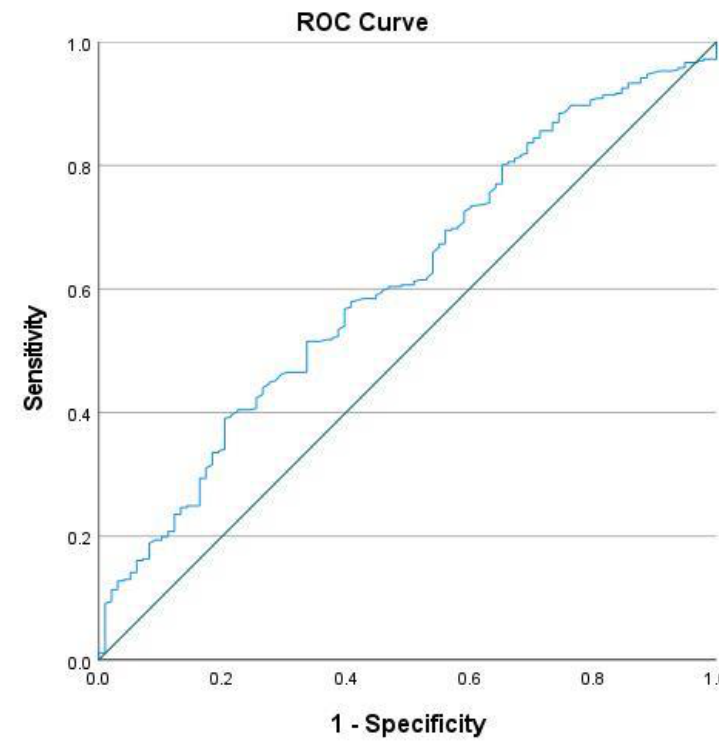
Figure 2. Receiver operating characteristic (ROC) curve (area under the curve (AUC) = 0.63; p = 0.001); larger values of the test result variable indicate stronger evidence for a positive actual